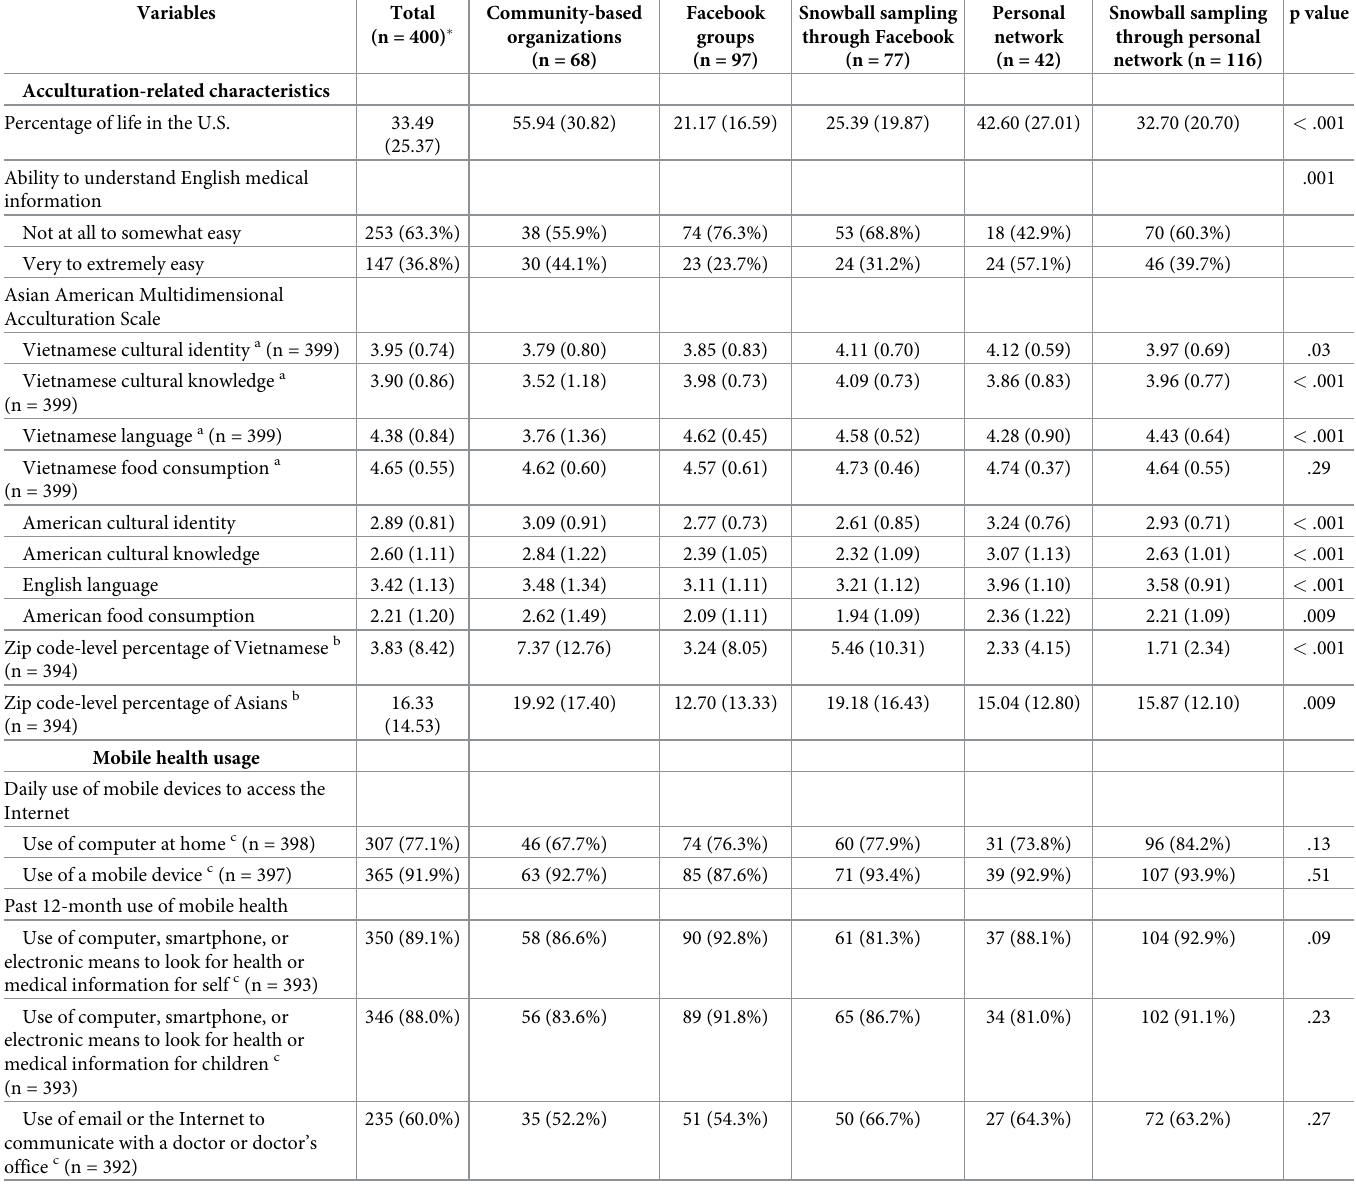
Table 3. Acculturation-related characteristics and mobile health usage in relation to recruitment methods. Variables